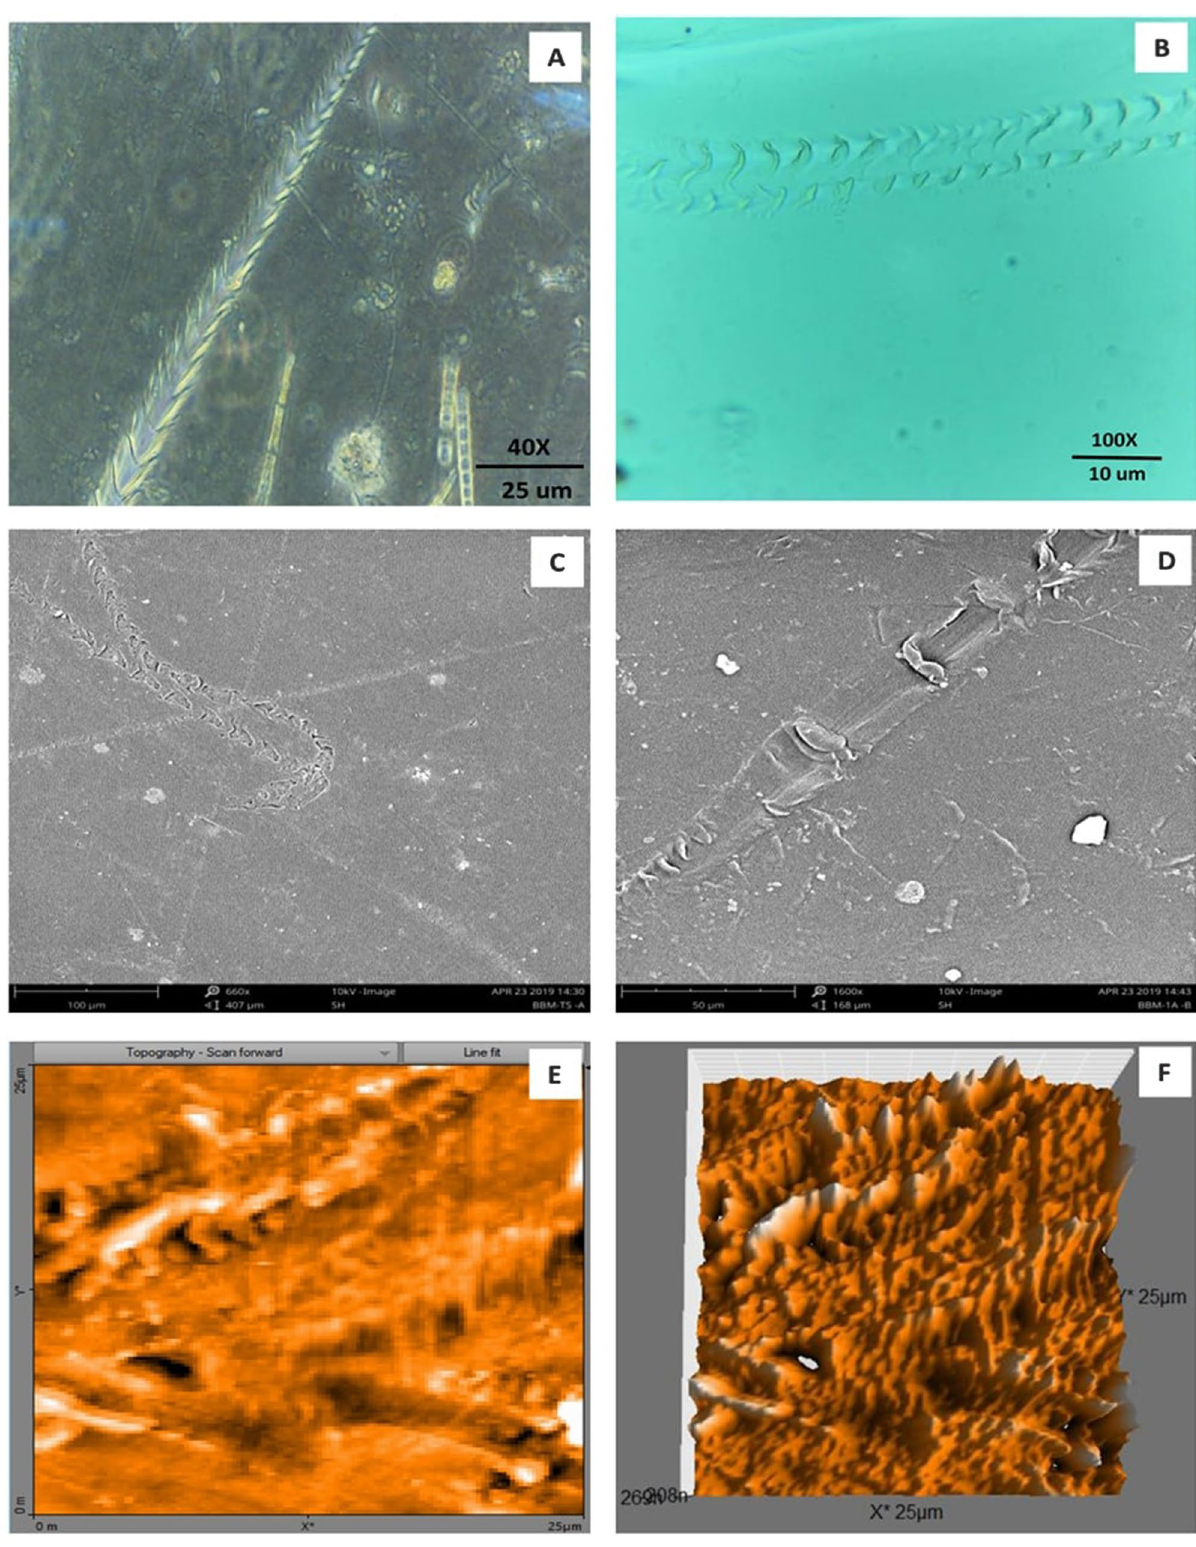
Figure 31. The images showing groove and ridges region on the surface of Uronema africanum treated LDPE sheet of different microscopical studies, such grooves and ridges were formed by the microalgal filaments; ( A ) Dark field microscopy; ( B ) Light microscopy; ( C , D ) SEM image of grooves and ridges formed by the microalga; ( E ) AFM—topography of the region where grooves and ridges were found; ( F ) AFM—topography—3D view of the region where grooves and ridges were